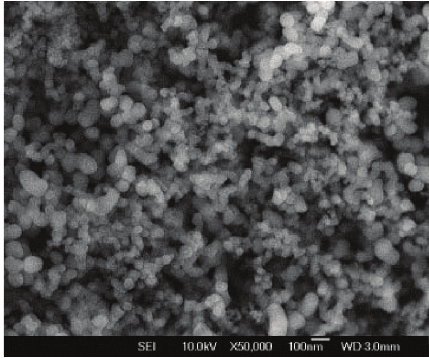
Figure 3: The morphology of NS obtained by using SEM.